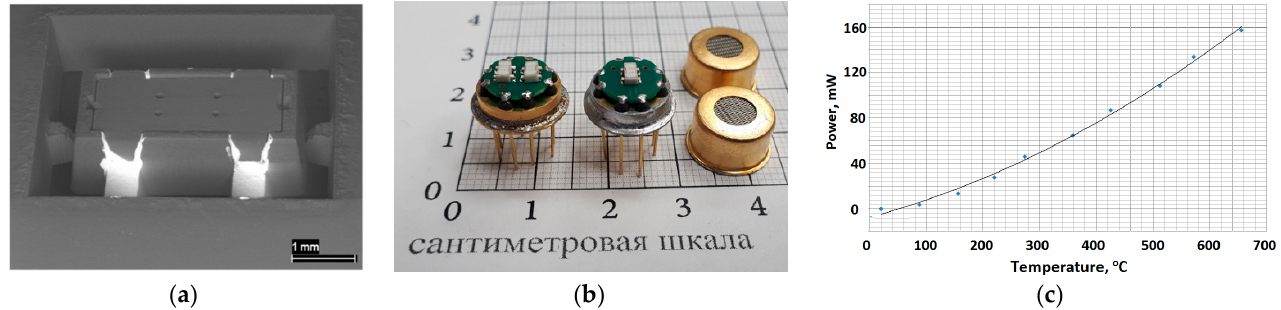
Figure 7. Result of sensor testing: ( a ) SEM image of fabricated sensor after final firing of Ag metallization on contact pads and before detachment from the ceramic substrate frame; ( b ) SOT-23 packages soldered on a PCB mounted in the metal-glass TO-8 package (diameter of top part is ~11 mm [27]), scale given in centimeters; and ( c ) power consumption for the MOX sensor in a SOT-23 package vs. working temperature.